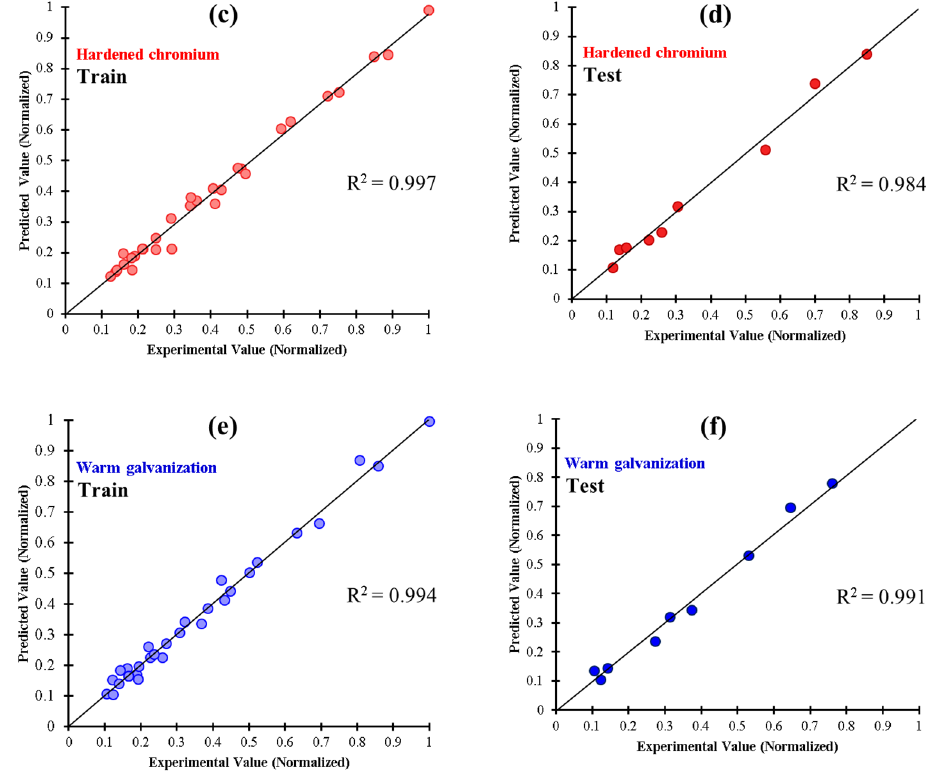
Figure 5. Comparison of the predicted and experimental values of fatigue life for training and testing steps considering the coated materials, including ( a , b ) Nickel, ( c , d ) Hardened chromium, and ( e , f ) Warm galvanization.